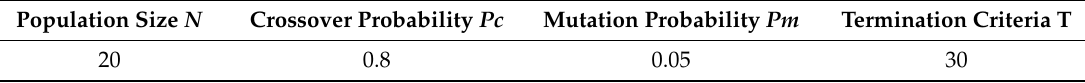
Table A9. GA feature selection parameter